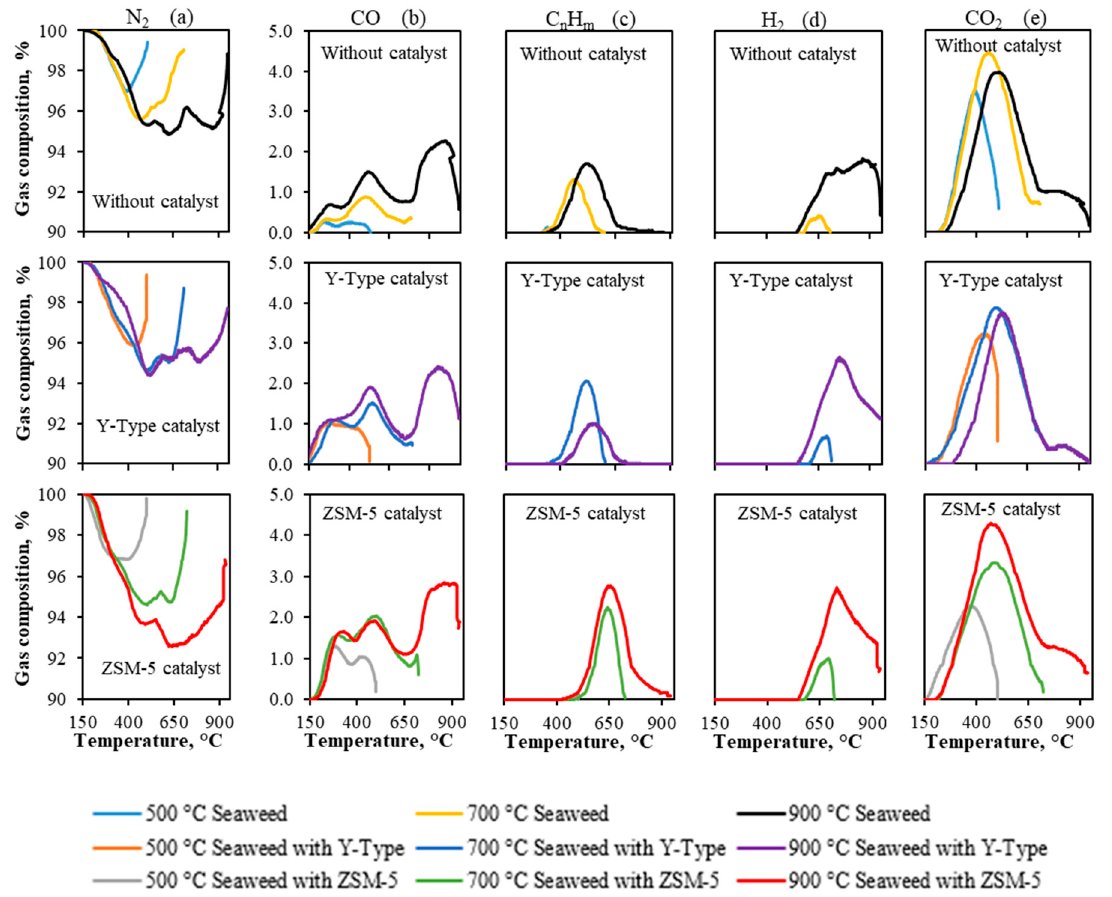
Figure 5. Gaseous product composition during the entire process.